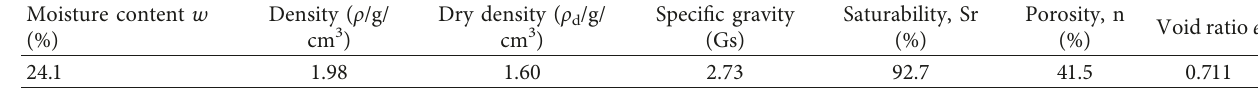
Table 1: Physical parameters of expansive soil.